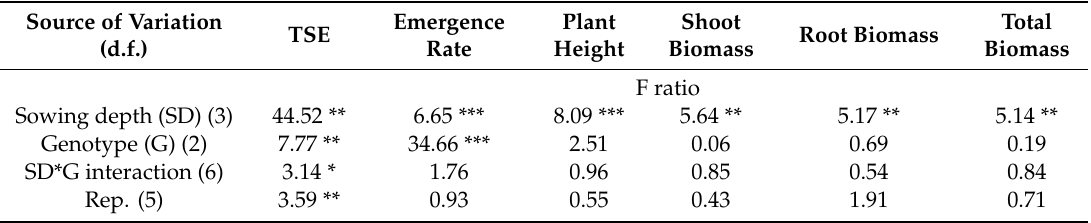
Table 3. Pot experiment. ANOVA for average time from sowing to emergence (TSE), emergence rate, plant height, and shoot, root and total biomass. Total Emergence Plant Shoot Source of Variation Root Biomass TSE Biomass Rate Height Biomass (d.f.) F ratio Sowing depth (SD) (3) 44.52 ** 6.65 *** 8.09 *** 5.64 ** 5.17 ** 5.14 ** Genotype (G) (2) 7.77 ** 34.66 *** 2.51 0.06 0.69 0.19 SD*G interaction (6) 3.14 * 1.76 0.96 0.85 0.54 0.84 Rep. (5) 3.59 ** 0.93 0.55 0.43 1.91 0.71 *, **, ***, significant at p < 0.05, 0.01, 0.001,